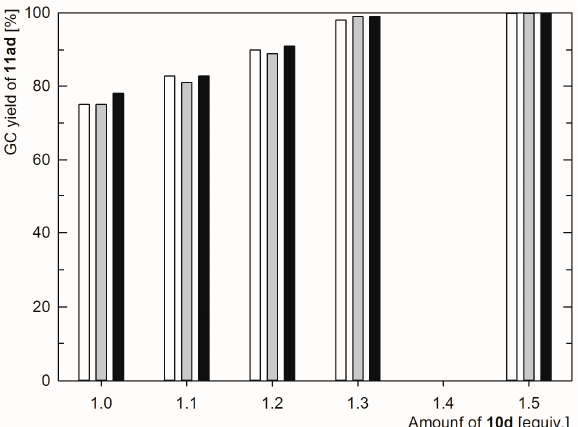
Figure 3. Variation in the gas chromatography (GC) yields of 11ad observed when changing the amount of acyl chloride in the reaction mixture. Conditions: catalyst 5 (0.5 mol.%), alkyne 9a (1 equiv.), triethylamine (5 equiv.), dodecane (1 equiv.; internal standard) in acetonitrile solvent at 50 °C. Reaction time: 1 h (white bars), 3 h (grey bars), and 8 h (black bars).